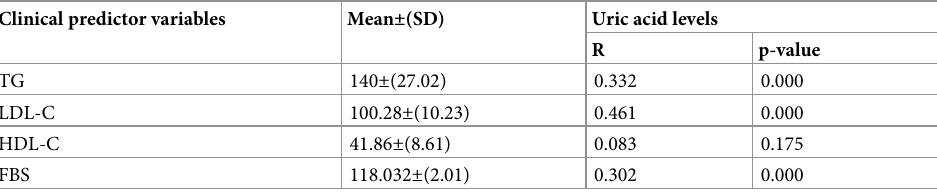
r = Pearson’s correlation coefficient, p = p-value for correlation, TG, triglyceride; HDL-C, high density lipoprotein; LDL-C, low density lipoprotein; FBS, fasting blood